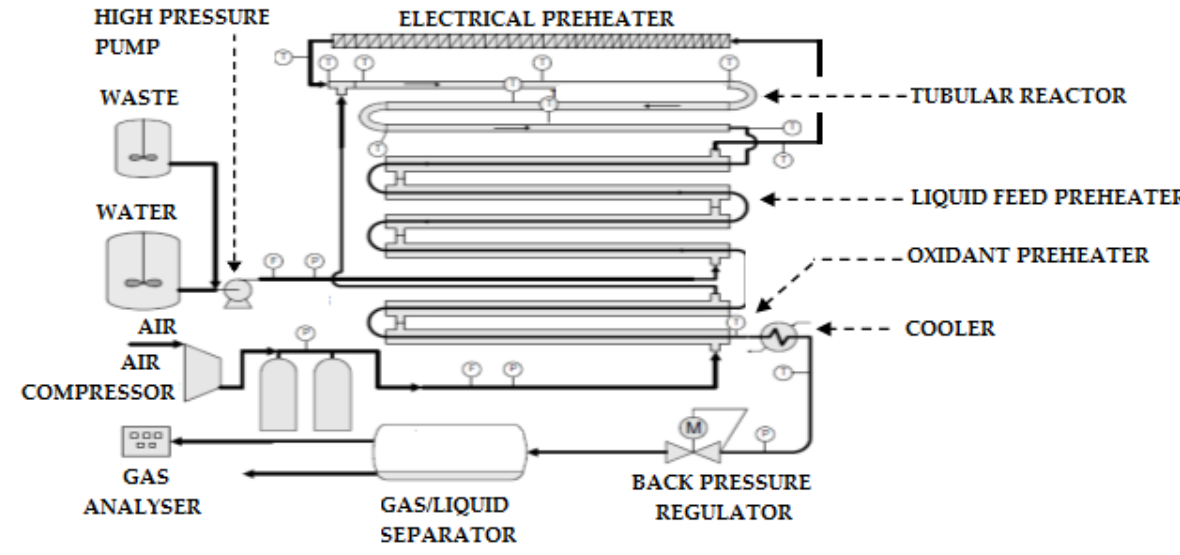
Figure 14. Pilot SCWO reactor [66].